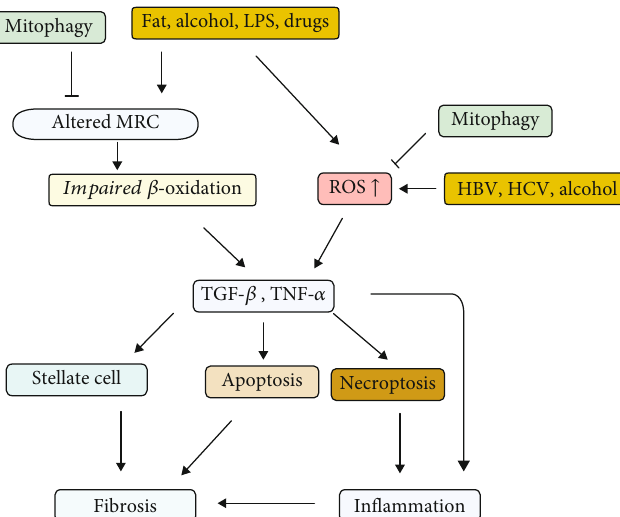
Figure 3: Mechanisms of mitochondrial involvement in hepatocyte death and fi brosis in chronic liver diseases. ROS can weaken β - oxidation, oxidize fat deposits, and prevent electrons from fl owing along with the MRC. Disease factors such as chronic viral infection can contribute to increasing ROS levels and accelerated lipid peroxidation. Lipid peroxidation products increase the hepatic production of TGF- β , which activates hepatic stellate cells, leading to fi brosis. ROS also increase the synthesis of TNF and several other cytokines in the liver, which can cause apoptosis and necroptosis. Necroptosis induces mitochondrial DAMPS, which contribute to the production of in fl ammatory cytokines that promote liver in fl